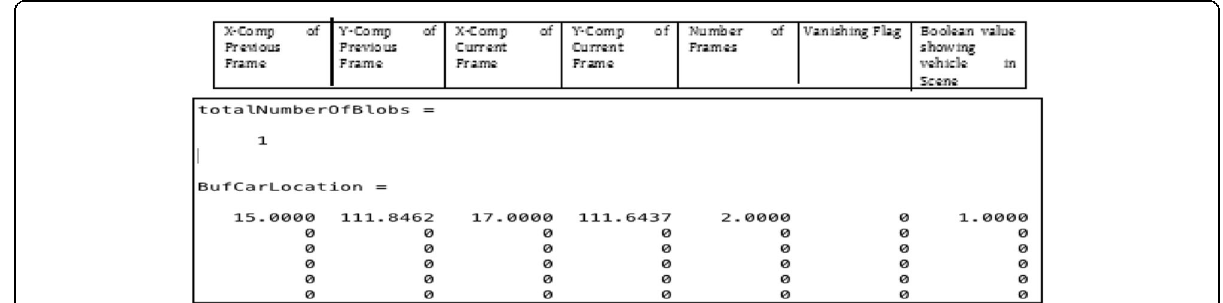
Fig. 13 Array of single vehicle coordinates and vehicle count